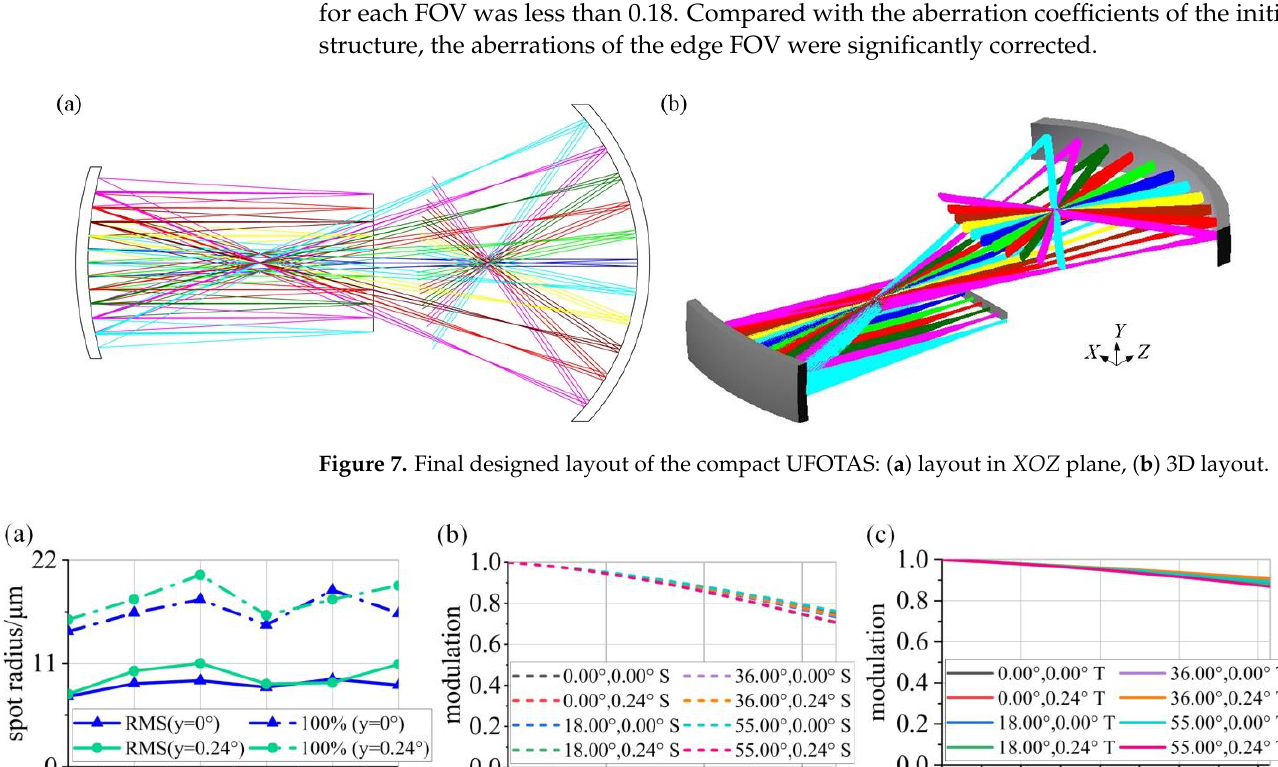
Figure 8. Performance analysis results of the UFOTAS: ( a ) spot diagram, ( b ) MTF in the X direction, ( c ) MTF in the Y direction.